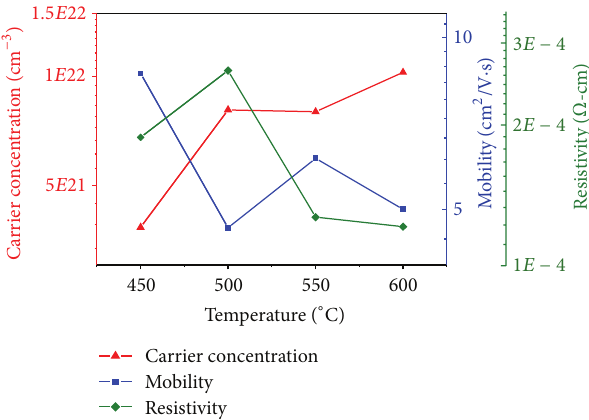
Figure4:Resistivity( 𝜌 ),hallmobility( 𝜇 ),andcarrierconcentration ( 𝑛 ) of the CIS absorber layers as a function of selenization tempera- ture the extra Se content was 0.2 g.